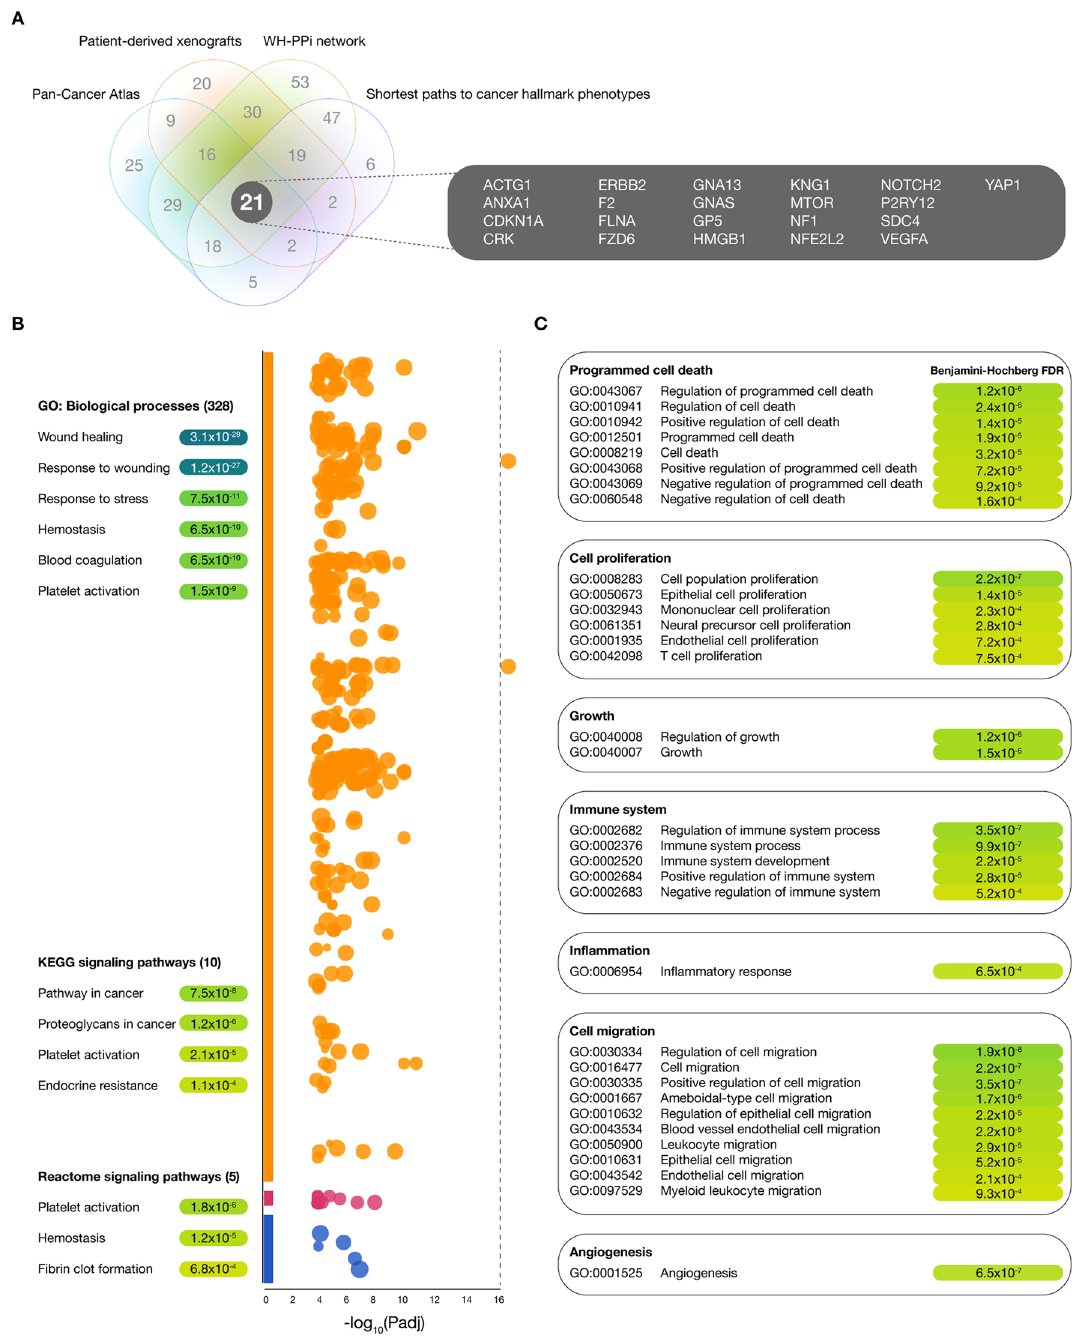
Figure 6. Integration of multi-omics approaches and functional enrichment analysis. ( A ) Venn diagram shows 21 wound healing proteins significantly expressed in the Pan-Cancer Atlas, the patient-derived xenografts, the wound healing protein–protein interactome network, and the shortest paths to cancer hallmark phenotype approaches. ( B ) Functional enrichment analysis showing a Manhattan plot of the most significant GO: biological processes, KEGG signaling pathways 107 , and Reactome signaling pathways 39 . ( C ) Functional enrichment analysis showing the most significant GO: biological processes related to hallmarks of cancer (programmed cell-death, cell proliferation, cell growth, immune system, inflammation, cell migration, and angiogenesis). Significant annotations were calculated through the Benjamini–Hochberg FDR q < 0.001. Lastly, the functional enrichment analysis was visualized by using the g:Profiler software version e101_eg48_p14_ baf17f0 (https:// biit. cs. ut. ee/ gprofi ler/ gost) 37,38